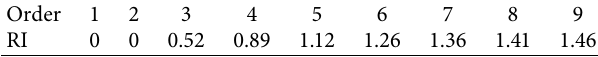
Table 2: Grade 9 grading table.